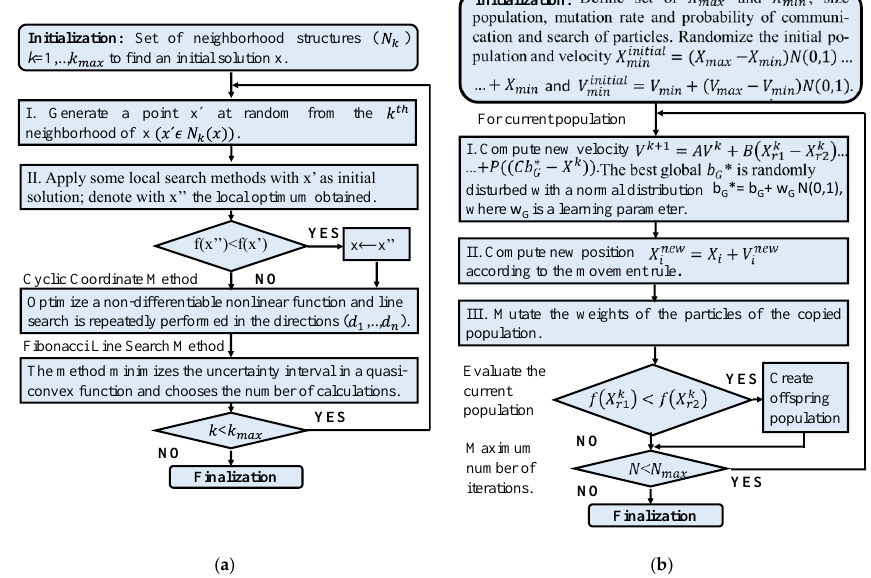
Figure 1. Algorithm flowchart: ( a ) variable neighborhood search (VNS); ( b ) differential evolutionary particle swarm optimization (DEEPSO). Code in detail available: http: // www.gecad.isep.ipp.pt / WCCI2018-SG-COMPETITION /